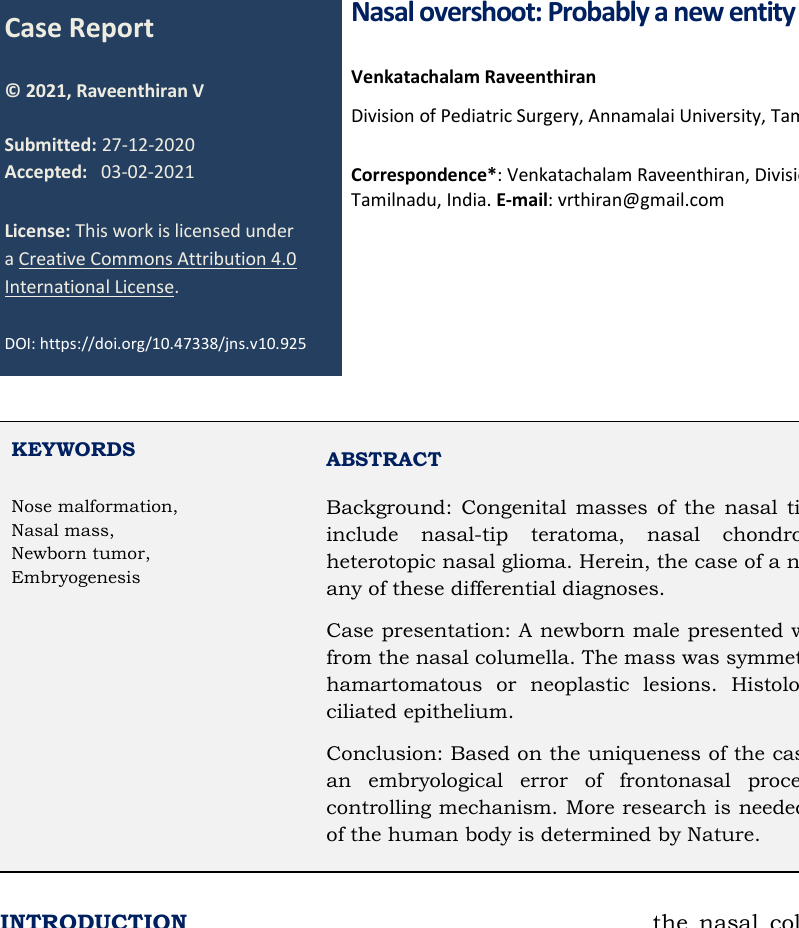
the nasal columella. A deep groove did separate the two symmetrical lobes (Fig 1).